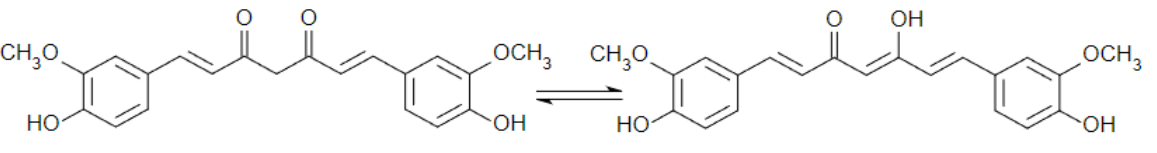
Figure 1. The keto-enol tautomeric structure of curcumin.